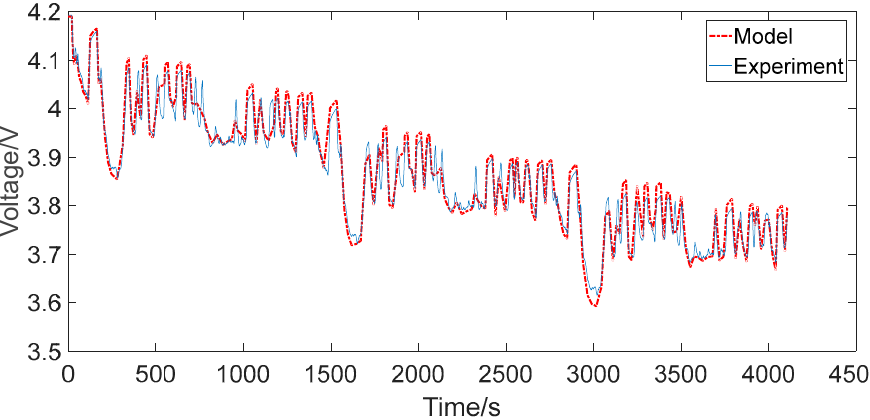
Figure 14. The simulation output of the first-order RC model for the urban dynamometer driving schedule (UDDS) cycle.